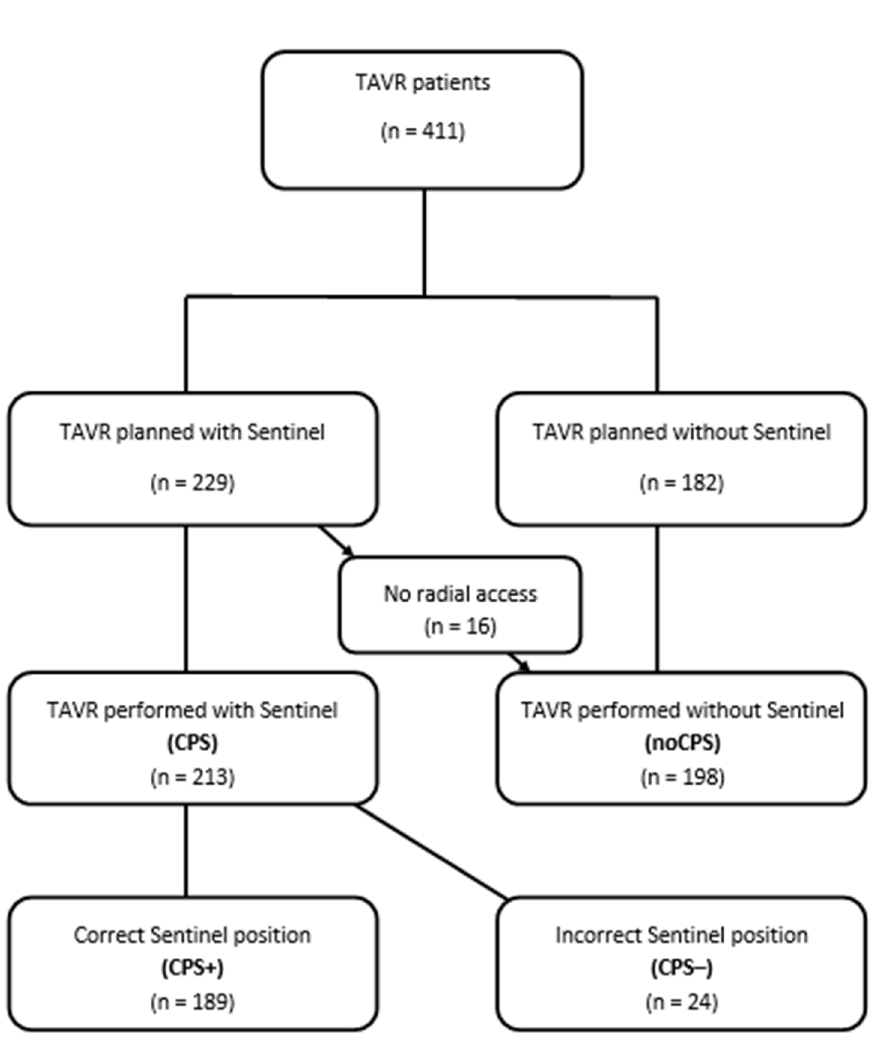
Figure 1. Patient flow. NoCPS indicates TAVR without Sentinel™, CPS indicates TAVR with Sen- tinel™. Patients in whom both filters were correctly deployed are presented as CPS+, patients with incomplete/incorrect CPS deployment are indicated as CPS −